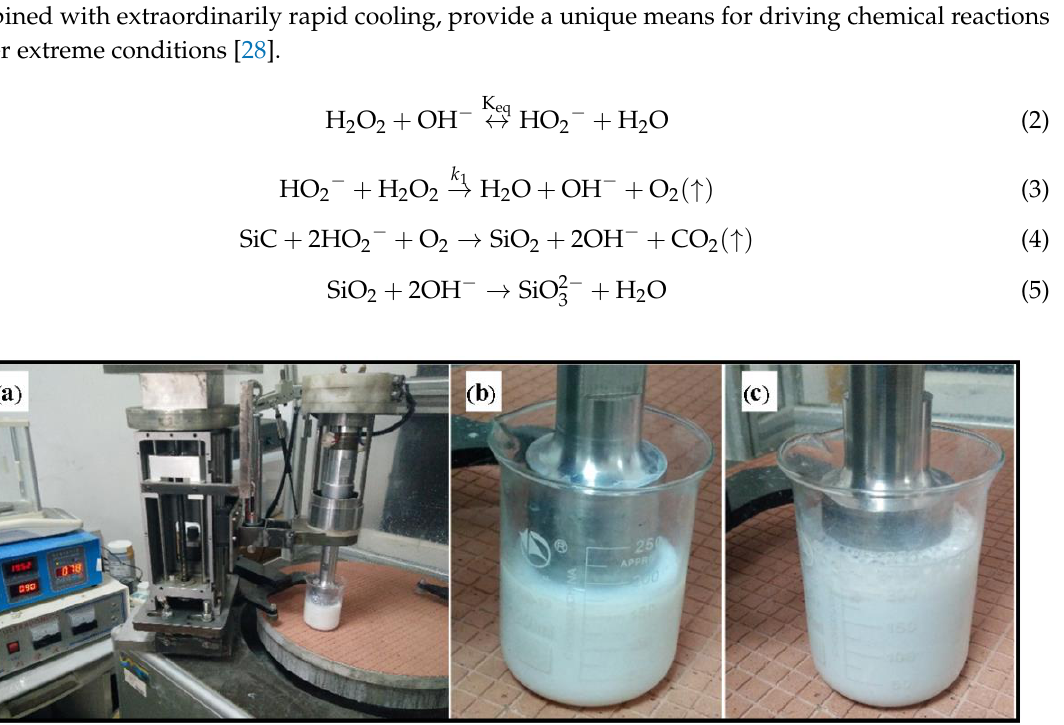
Figure 3. Physical picture of chemical corroding using CMP slurry: ( a ) Equipment for chemical corroding; ( b ) conventional chemical corroding; ( c ) ultrasonic chemical corroding.